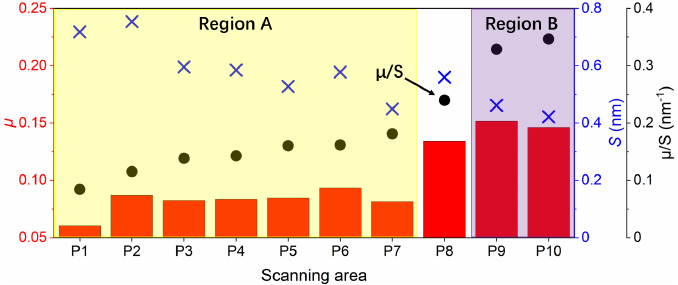
Figure 4. Friction coefficient, surface roughness and their ratio determined from ten random areas for sample 5% H, which are arranged by the the increasing µ / S ratio.